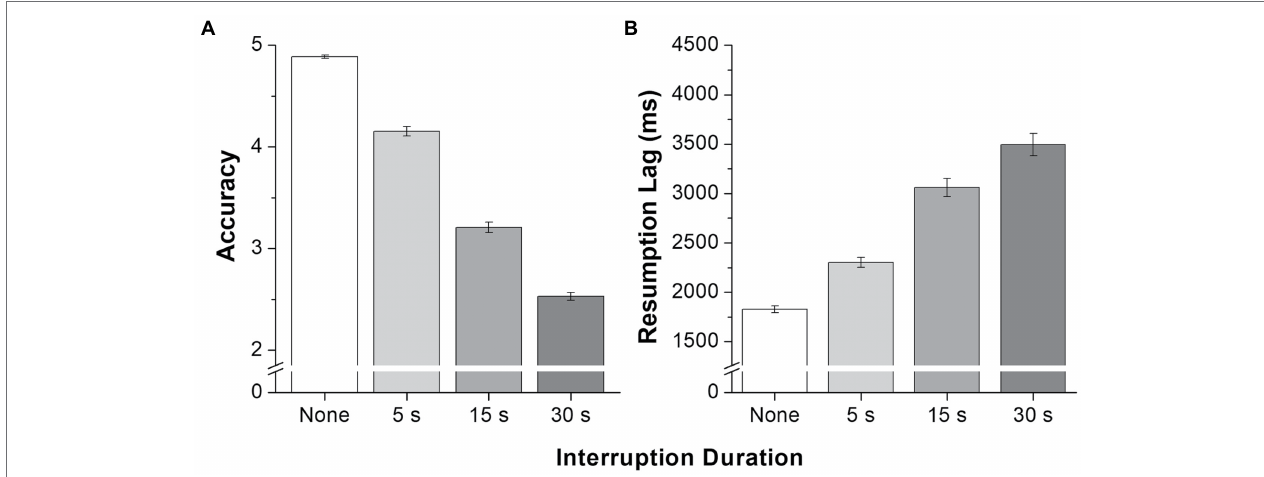
FIGURE 3 | Mean number of target dots correctly identified (A) and mean resumption lag (B) according to interruption duration. Error bars represent the standard error of the